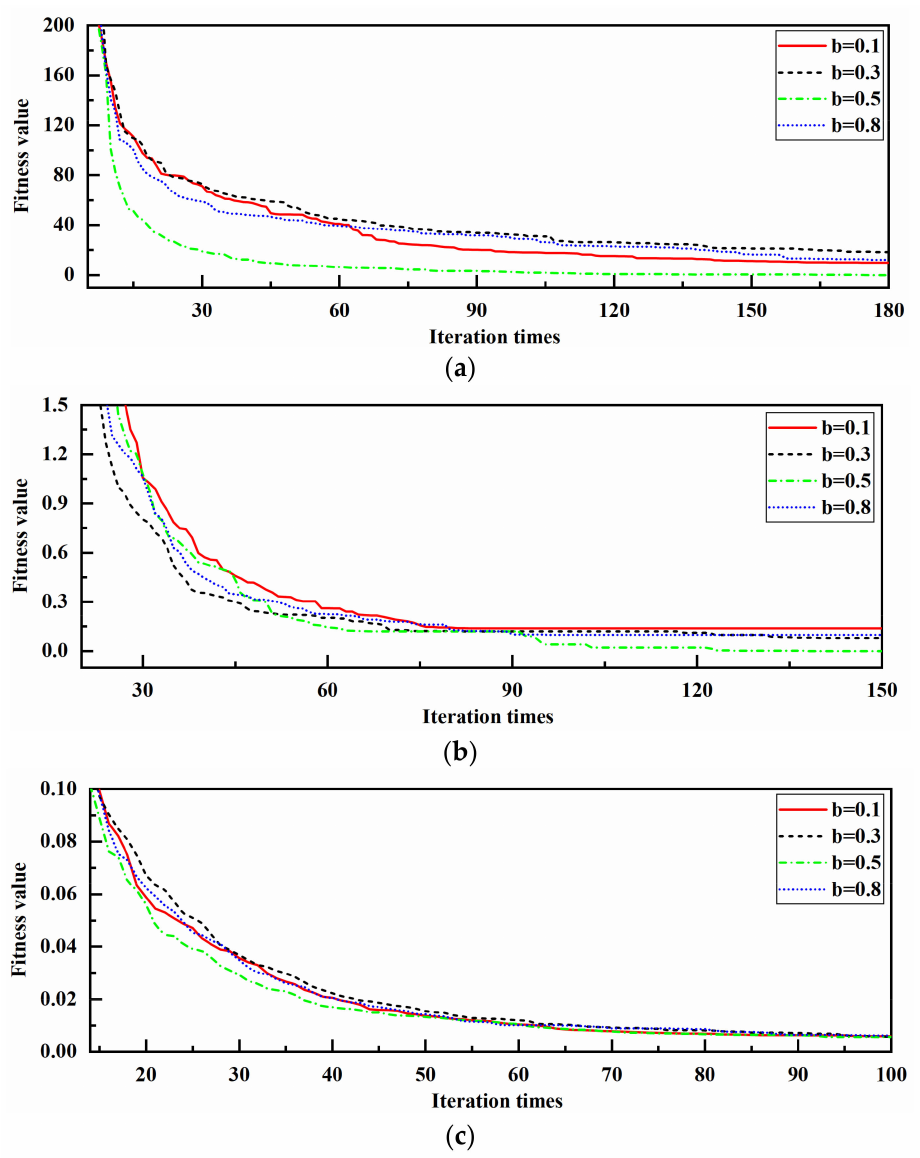
Figure 4. Influence of parameter b on SIPSO algorithm. ( a ) Curve of Rosenbrock function; ( b ) curve of Rastrigin function; ( c ) curve of Griewank